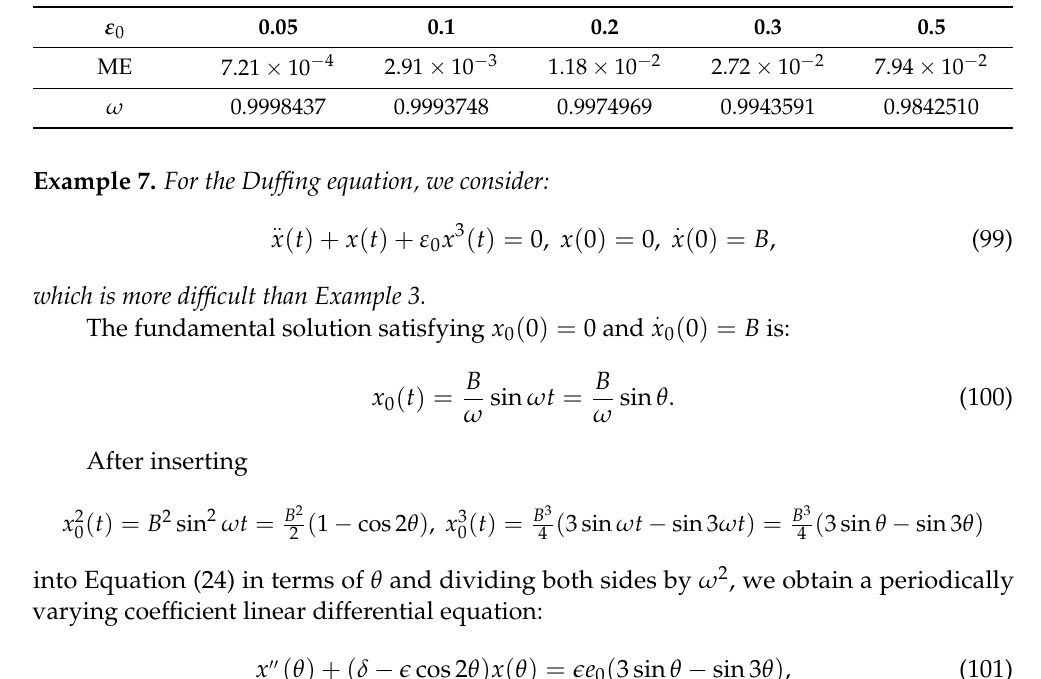
Figure 4. For the van der Pol equation with A = 2.5, comparing the exact solution obtained by the RK4 and the solution obtained by the present method: ( a ) time histories of displacement and ( b ) phase portraits in the phase plane Table 6. The maximum errors and frequencies obtained by the present method for the analytic solutions of Example 6 with different ε 0